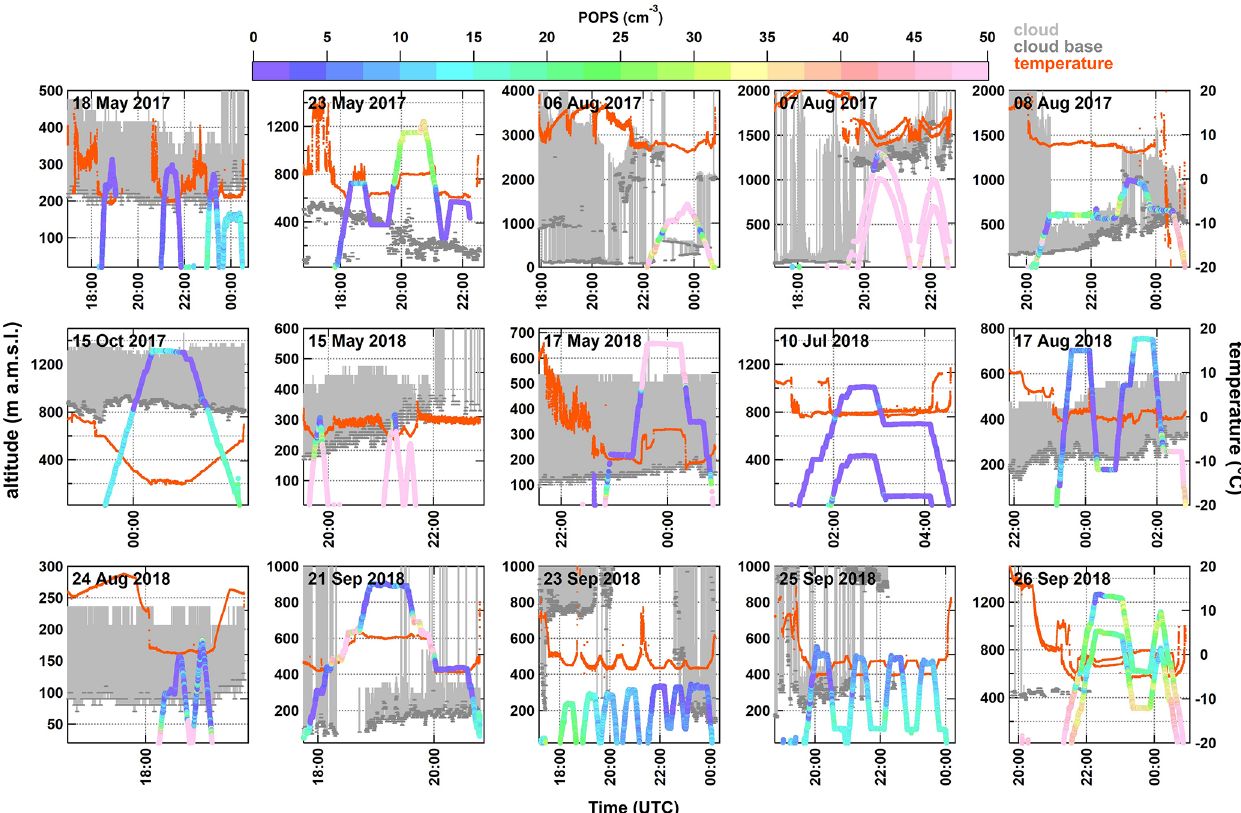
Figure 3. Data from select flights from ICARUS, AVPOP, and POPEYE. Colored lines show the altitude of the POPS instruments (left axes) where the color scale represents aerosol number concentration. Days with two lines indicate both POPS were deployed and operational and demonstrate the relative location of each POPS on the tether. Orange lines represent the temperature measured by the iMet instruments (right axes), and like the POPS some flights contained multiple iMet sensors. The dark grey markers represent cloud base as measured by the ground-based ceilometer, and the lighter shaded grey region indicates the location and depth of the clouds as measured by the KAZR radar. One clear-sky case is shown (10 July 2018).